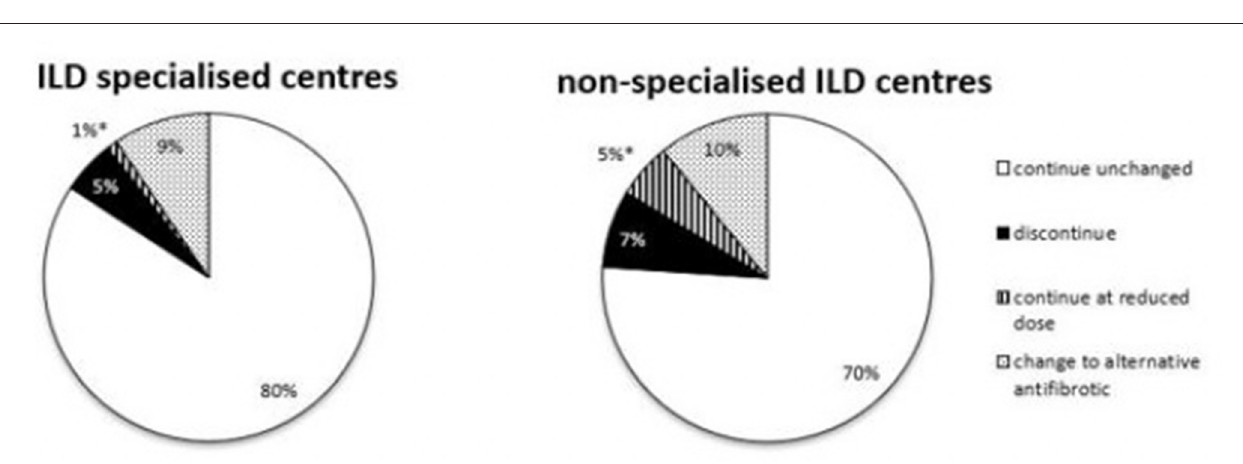
FIGURE 4 | Different strategies in AE-IPF concerning an antifibrotic treatment in specialised and non-specialised ILD centres. Statistically significant differences are labelled with a * (p-value = <